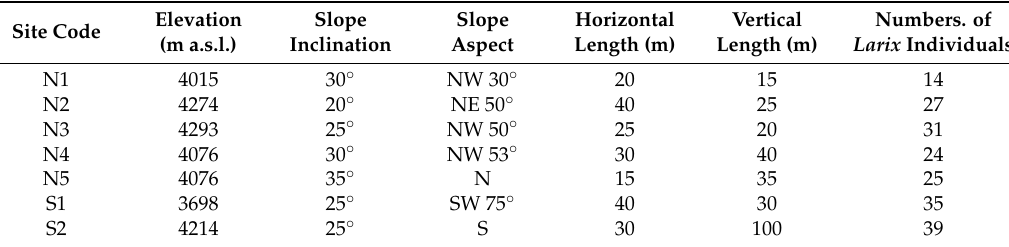
Table 1. Characteristics of seven sampling sites in the eastern Tibetan Plateau (TP) and the numbers of sampled individuals.